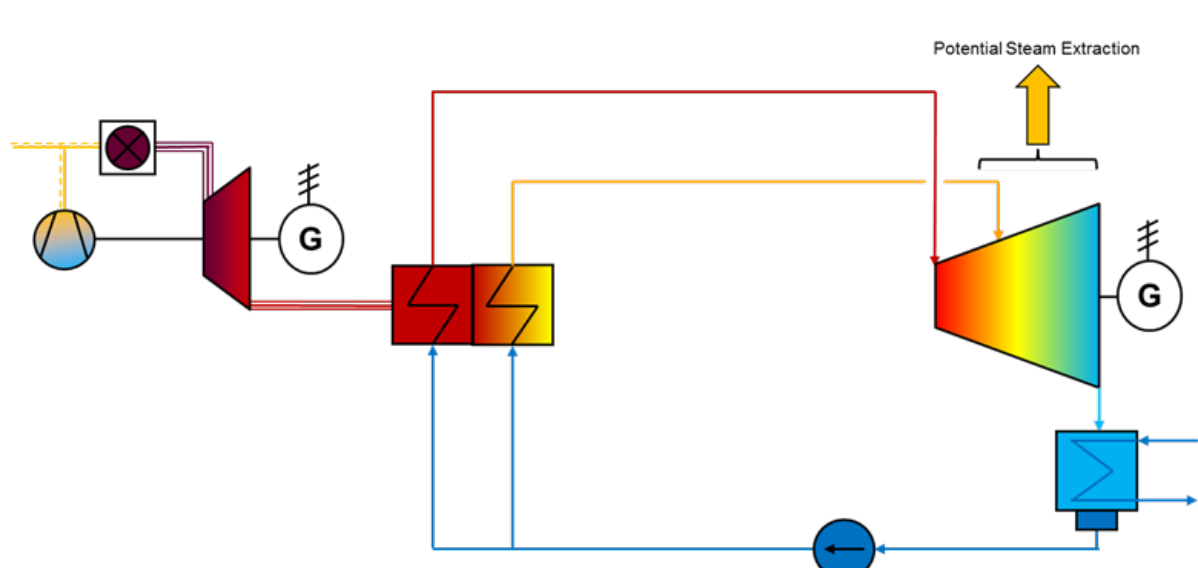
Figure 5. Double Pressure Non Reheat CHP Cycle